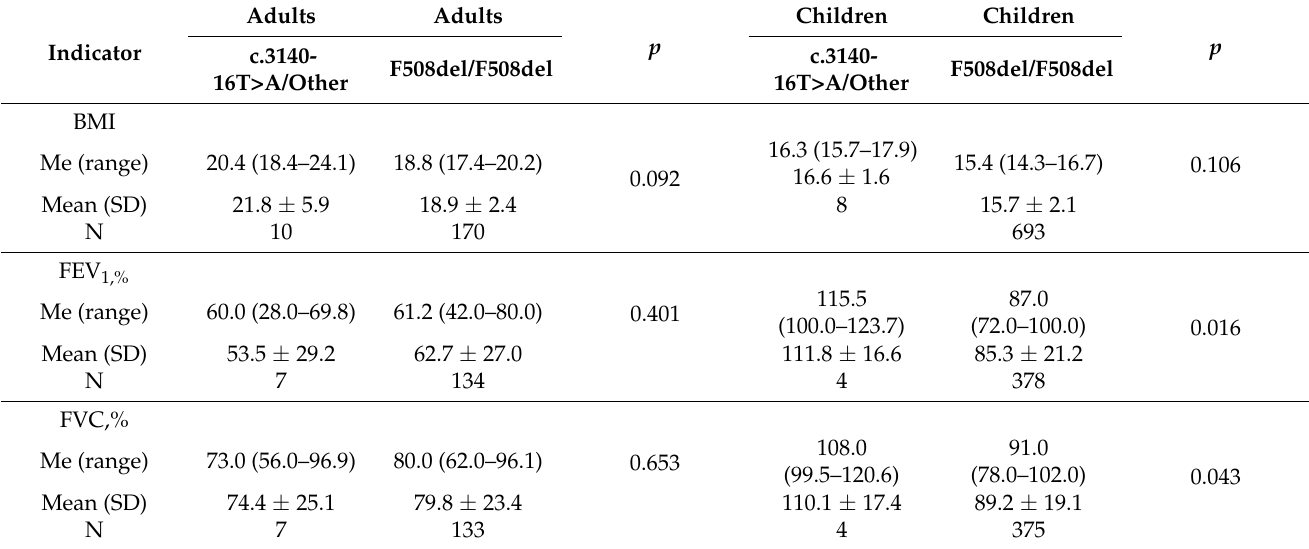
Table 2. Characteristics of children and adults with cystic fibrosis with different